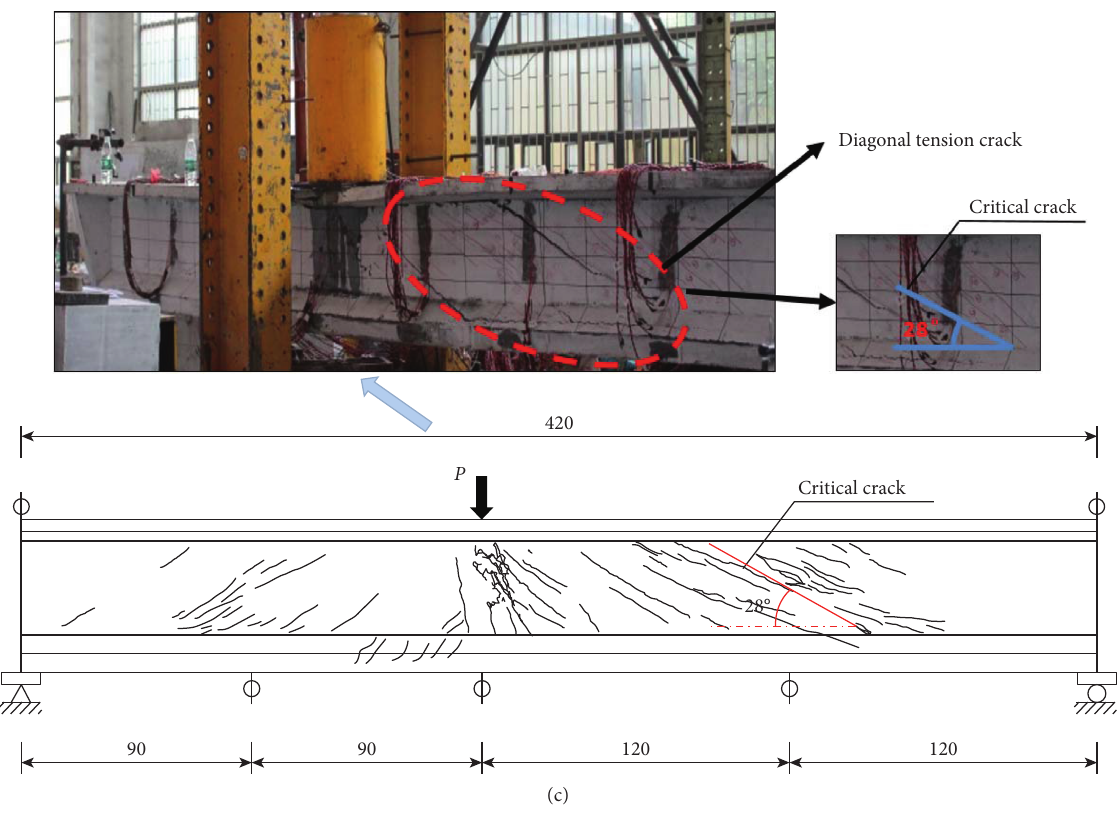
Figure 13: Failure modes of the test beams. (a) L1, (b) L2, and (c)